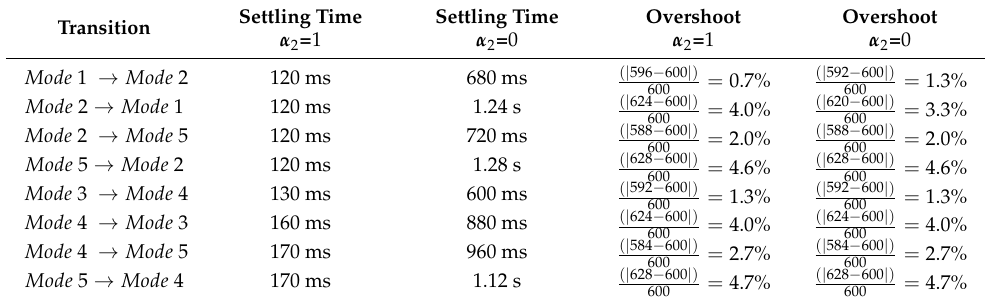
Figure 20. Transient behavior for 𝛼 (cid:2870) = 0 ( a ) mode 1 to mode 2, ( b ) mode 2 to mode 5, ( c ) mode 3 to mode 4, ( d ) mode 4 to mode 5. Table 5. Results compiled.